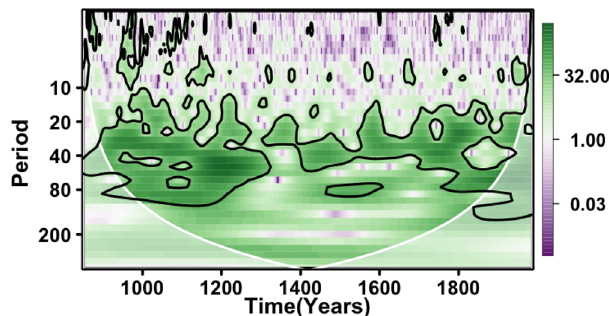
Fig. 4 | Discrete wavelet transform of the nested Atlantic Multidecadal Varia- bilityreconstructionfromthisstudy. Contoursprovidethe90%con fi dencelevel of signi fi cance. The white line and the light white-shaded area below indicate the coneofin fl uence.Theconeofin fl uencegivesthespectrumborderswheretheedge effect (i.e., the time boundary effect) becomes too important, which cannot be robustly